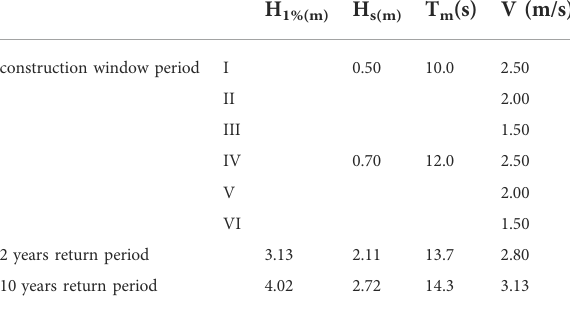
TABLE 3 Wave and current